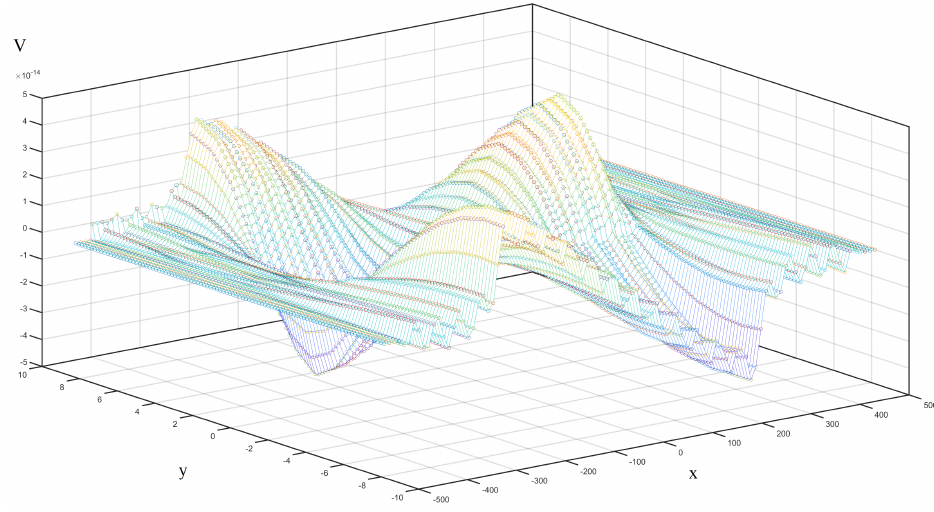
Figure 11. Vertical displacement of mode 1.